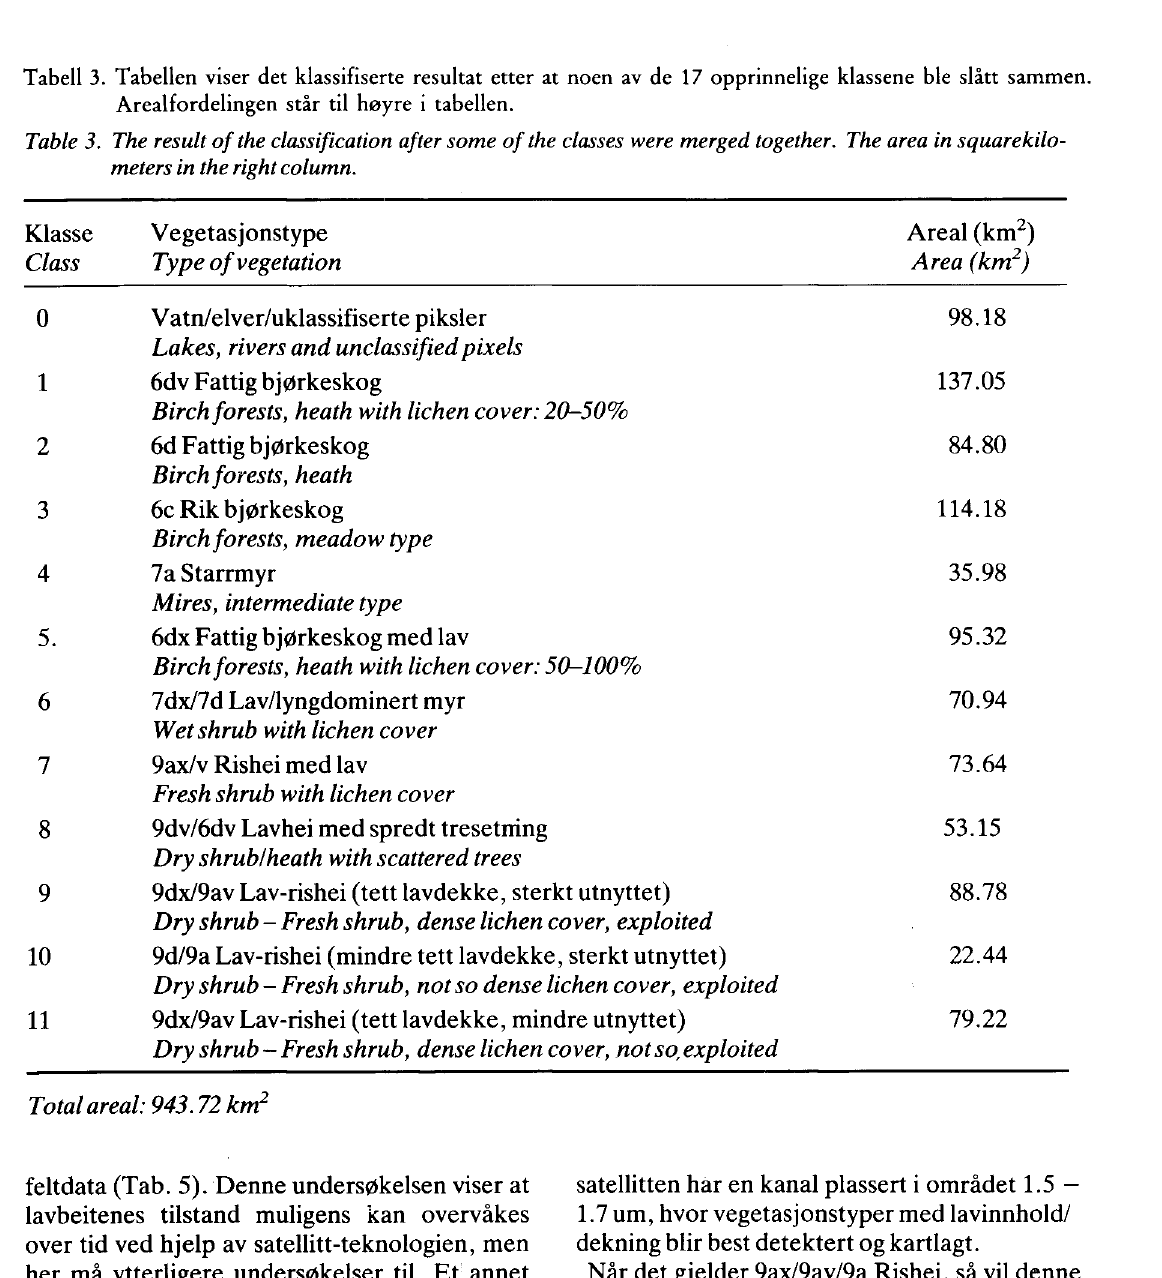
Tabell 3. Tabellen viser det klassifiserte resultat etter at noen av de 17 opprinnelige klassene ble slått sammen. Arealfordelingen står til høyre i tabellen. Table 3. The result of the classification after some of the classes were merged together. The area in squarekilo¬ meters in the right